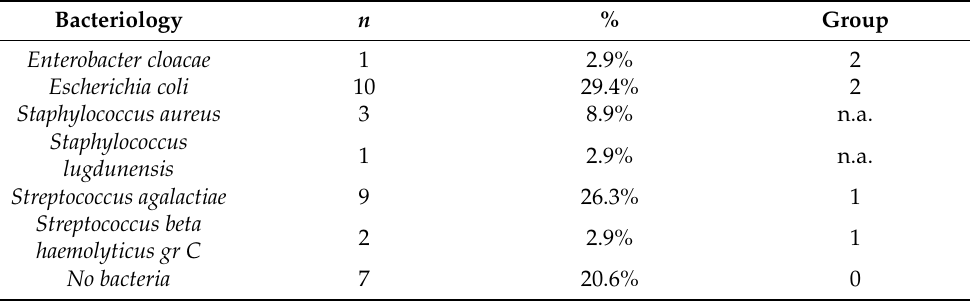
Table 2. The bacteriology of patients with cervical cancer